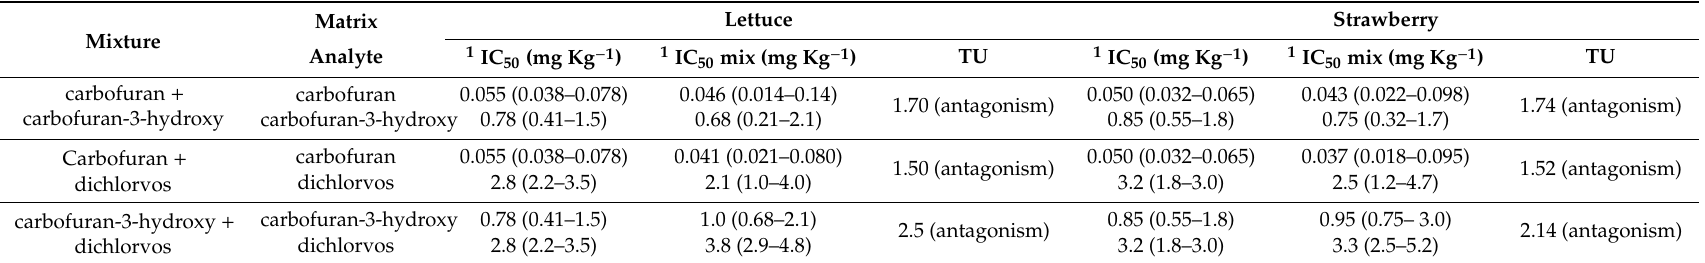
Table 4. IC 50 for the tested binary mixtures in lettuce and strawberry extracts. TU were calculated as explained in Section 2.7. TU < 1, TU = 1, TU > 1 shows synergism, dose addition and antagonism,